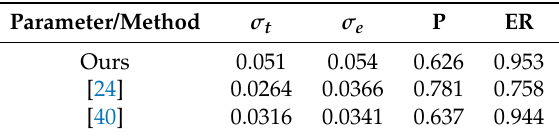
Table 9. Comparison in terms of entropy